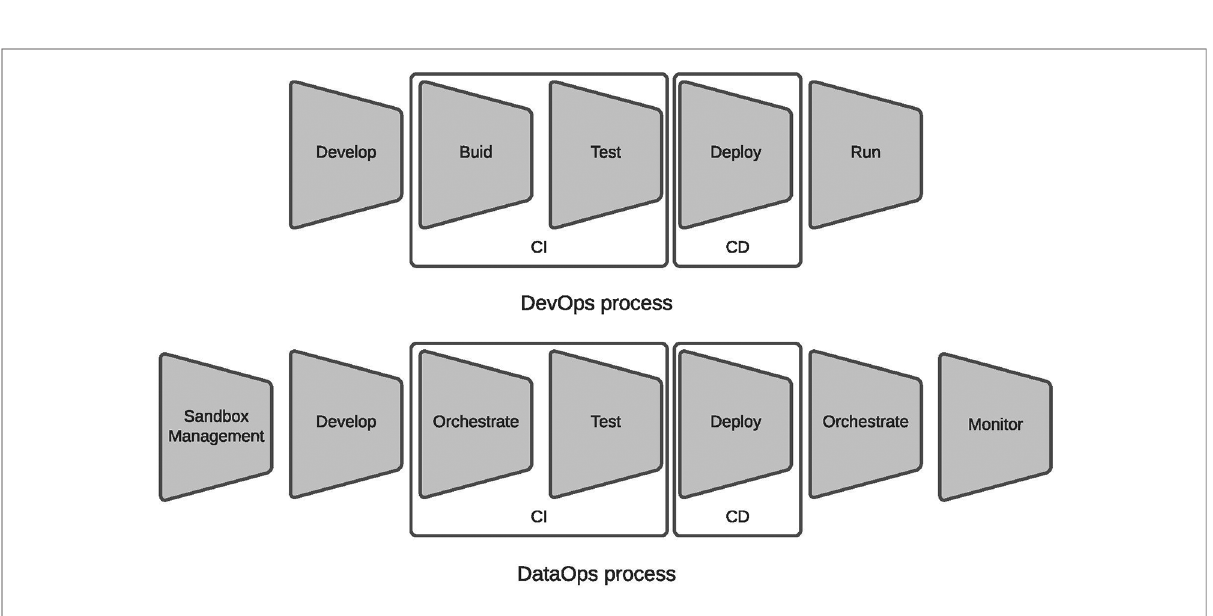
FIGURE 2 DevOps and DataOps processes (17).